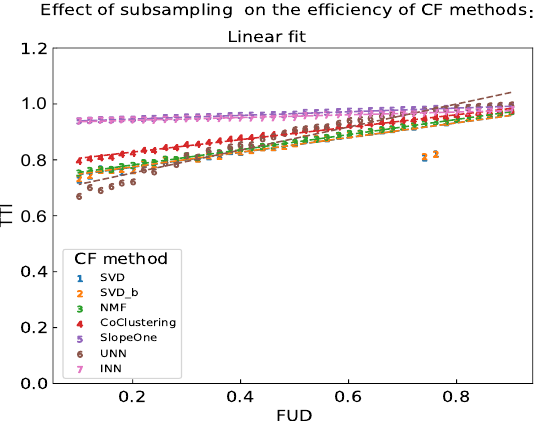
Fig. 3 TTI versus FUD using P 1 at constant FID